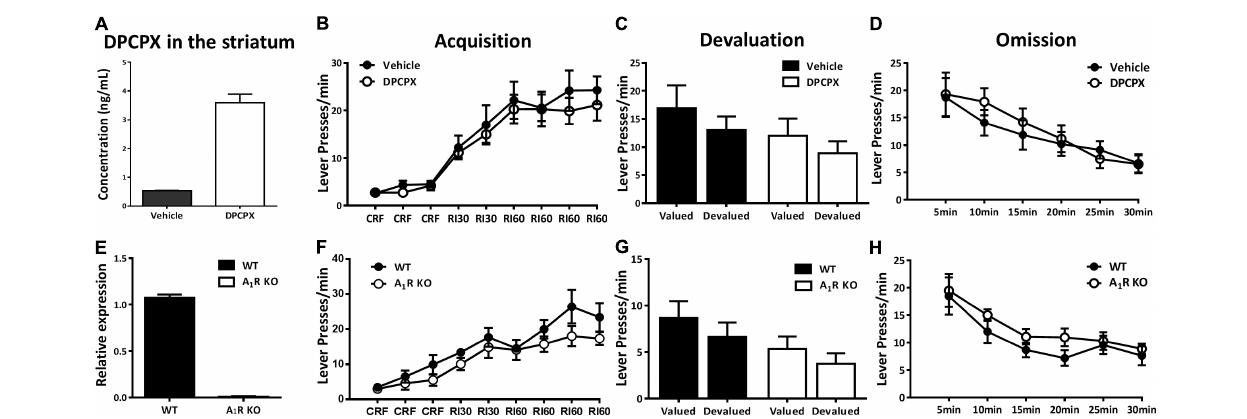
FIGURE 4 | Pharmacological blockade and genetic knockout of A 1 Rs did not affect action-outcome association or goal-evaluation of instrumental behavior. (A) The concentration of DPCPX was detected in the striatum of mice 30 min after drug administration ( n = 3/group), demonstrating the effectiveness of drug level we used. (B) Mice with and without DPCPX manipulation performed analogical learning curves in the acquisition of instrumental conditioning (between-subject effect, p = 0.597; drug administration X training interaction effect, p = 0.867). (C) Both DPCPX ( p = 0.131) and vehicle ( p = 0.370) groups displayed insensitive to outcome devaluation. (D) There didn’t show any difference between DPCPX and vehicle groups in the omission test (between-subject effect, p = 0.724; drug administration X testing time interaction effect, p = 0.580). (E) The knockout efficiency of A 1 R KO mice was confirmed by qPCR. (F) A 1 R knockout did not affect acquisition of instrumental behavior since there lack of main effect of genotypes ( p = 0.219) and training sessions X genotypes interaction effect ( p = 0.355). (G) A 1 R knockout mice and their littermates did not significantly decrease lever presses rate in the devalued condition (A 1 R KO group, p = 0.228; WT group, p = 0.263). (H) Both groups decreased their lever presses indistinctively in the omission test (genotypes main effect, p = 0.239; genotypes X testing time interaction effect, p = 0.817). All data was analyzed by two-way ANOVA for repeated